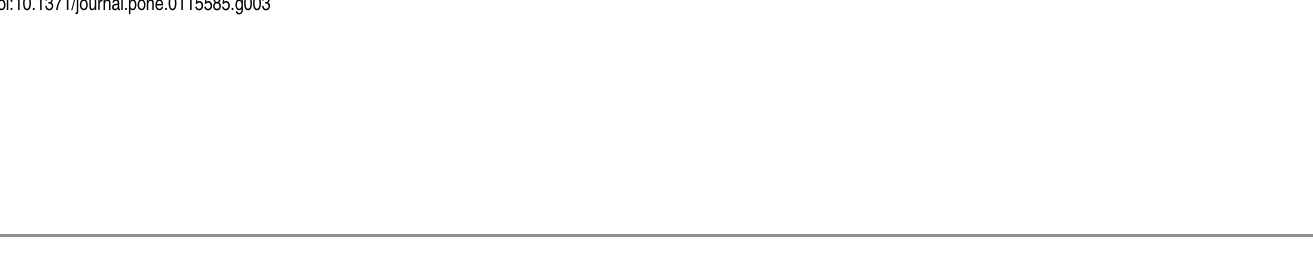
PLOS ONE | DOI:10.1371/journal.pone.0115585 December 26,